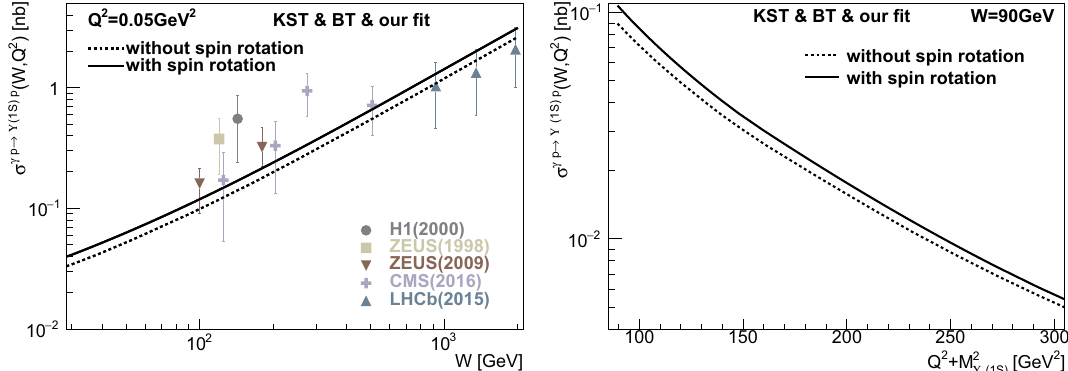
(right panel) J /ψ